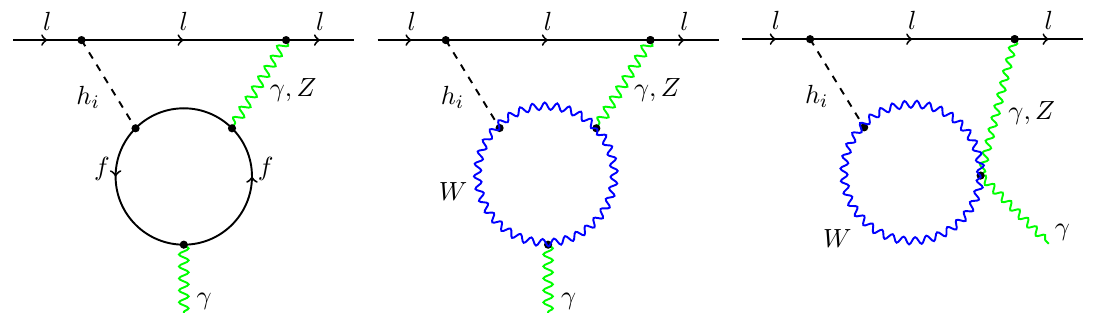
Figure 3 . The Barr-Zee diagrams with largest contributions to muon anomalous magnetic moment ( l = (cid:22) ) and eEDM ( l = e